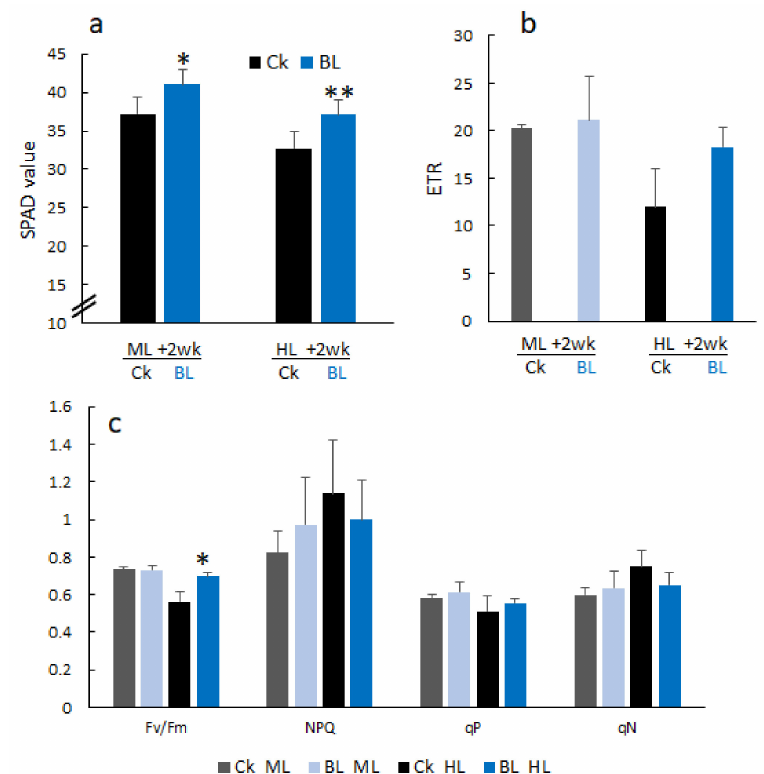
Figure 3. Photosynthesis of young orchid seedlings at two weeks after moderate and high light treatments, respectively. ( a ) SPAD value. ( b ) Electron transport rate (ETR). ( c ) Chlorophyll fluorescence parameters of Fv / Fm, non-photochemical quenching (NPQ), photochemical quenching of fluorescence (qP) and non-photochemical quenching of fluorescence (qN). ML, moderate light at 500 µ mol m − 2 s − 1 . HL, high light at 1000 µ mol m − 2 s − 1 . Significant di ff erences in comparison with the control without BL acclimation (BL) are indicated with an asterisk. Statistical significance was determined by a one-way analysis of variance (ANOVA), followed by a Dunnett’s test. *, p < 0.05; **, p < 0.01. Error bars represent the standard error of the mean ( n =